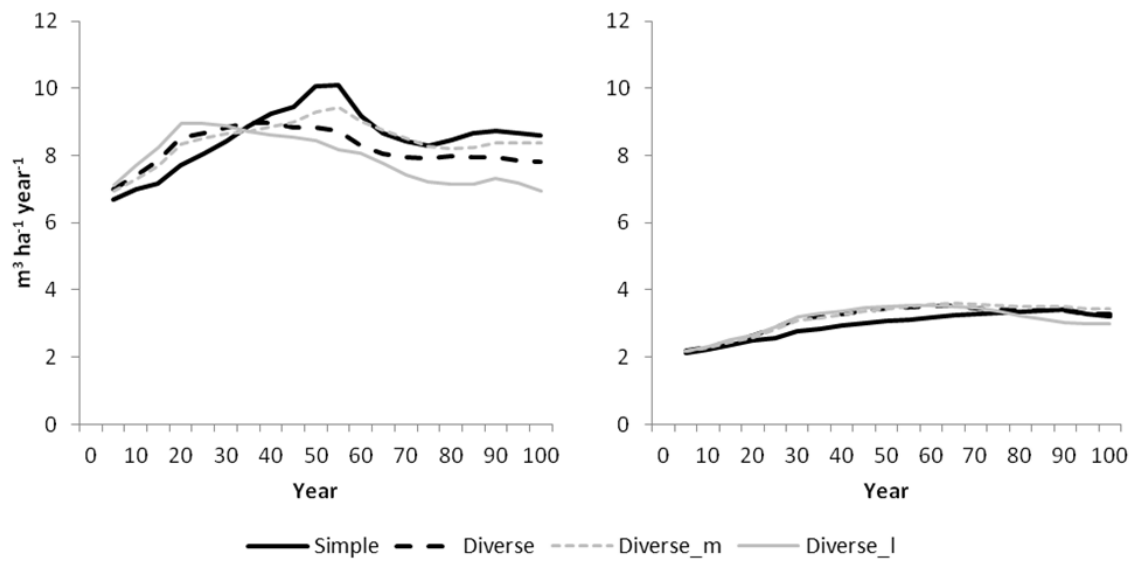
Figure 5. Development of the net annual volume increment (m 3 /ha/year) in Hässleholm ( left ) and Vilhelmina ( right ) for the Simple and Diverse scenarios, as well as the more intensive (Diverse_m) and less intensive (Diverse_l) variations of the Diverse